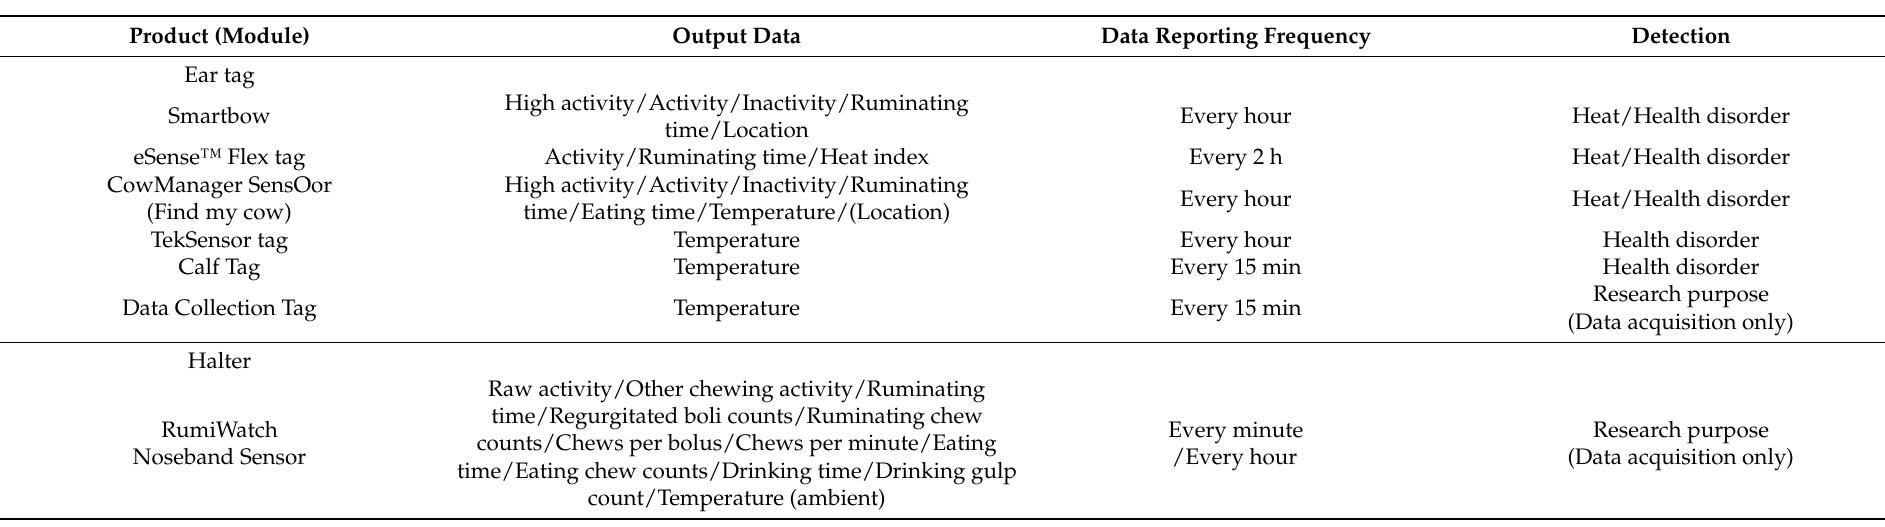
Table 2. Output data and detection items of the wearable wireless biosensor systems (ear tag and halter